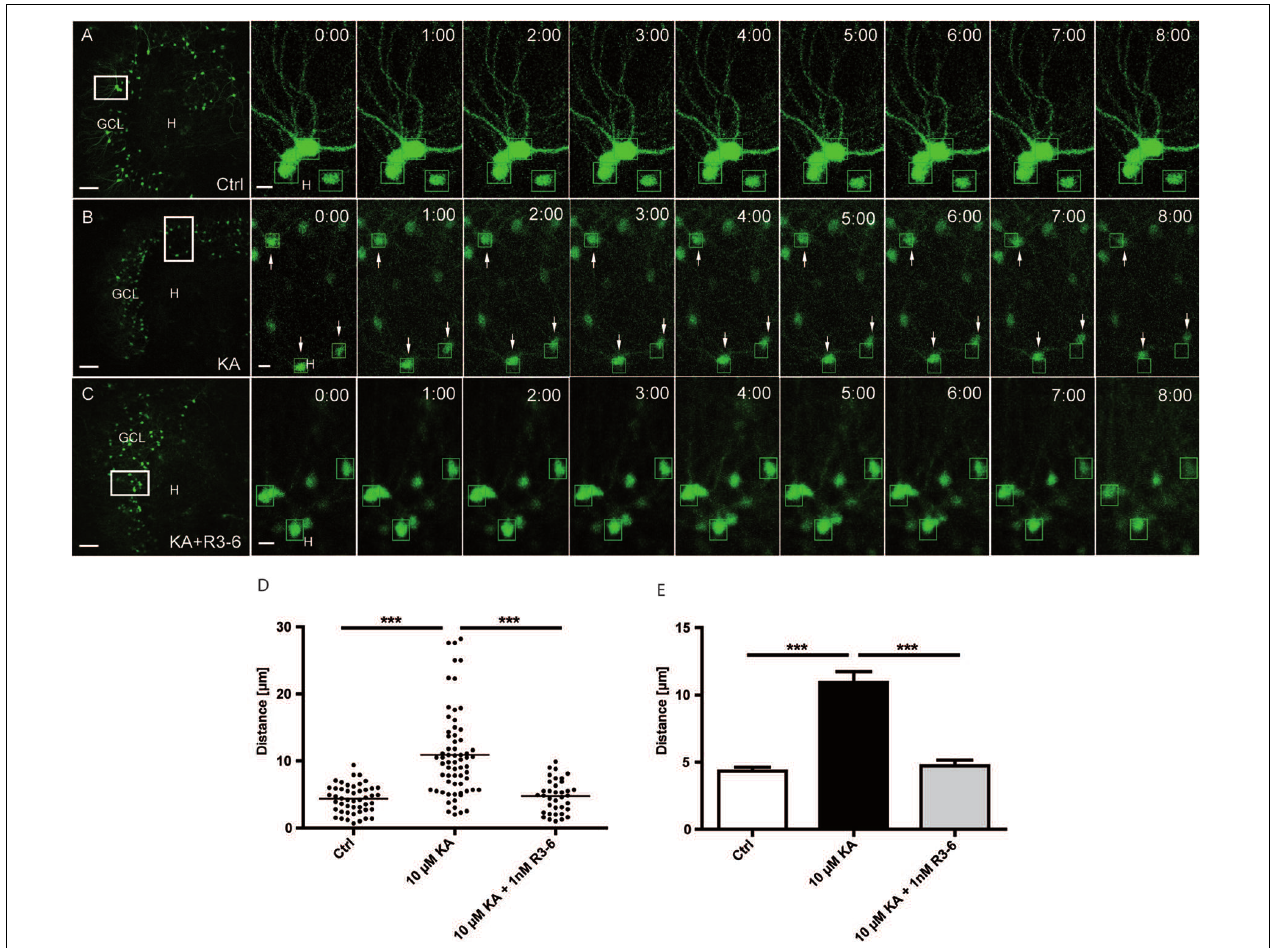
FIGURE 5 | Kainate-induced migration of differentiated granule cells is prevented by the central R3–6 Reelin fragment. Live cell imaging of individual eGFP-positive granule cells was performed over a period of 8 h, and migration distances of randomly selected cells were assessed as described in Section “Materials and Methods.” Representative confocal micrographs of nine imaging time points are shown for each condition. Left panel: overview; white frame indicates the area shown at high magnification on the right. Tracked cells are marked by green frames. (A) Untreated control ( n = 8; 48 cells). Cells do not change position. (B) Treatment of OHSC with 10 µ M KA for 45 min ( n = 10; 60 cells). Granule cells (GCs) with high motility are indicated by arrows. (C) Treatment of OHSC with 10 µ M KA for 45 min, followed by incubation with fresh medium and subsequent application of recombinant R3–6 Reelin fragment (1 nM; n = 6; 36 cells). Like controls, cells do not change position. (D,E) Quantitative evaluation of migration distances of individual GCs. KA-treated GCs migrate, but not in the presence of the recombinant R3–6 Reelin fragment. One-way ANOVA, followed by Tukey’s Multiple Comparison Test ( ∗∗∗ P < 0.001; Ctrl vs. 10 µ M KA + 1 nM R3–6 shows